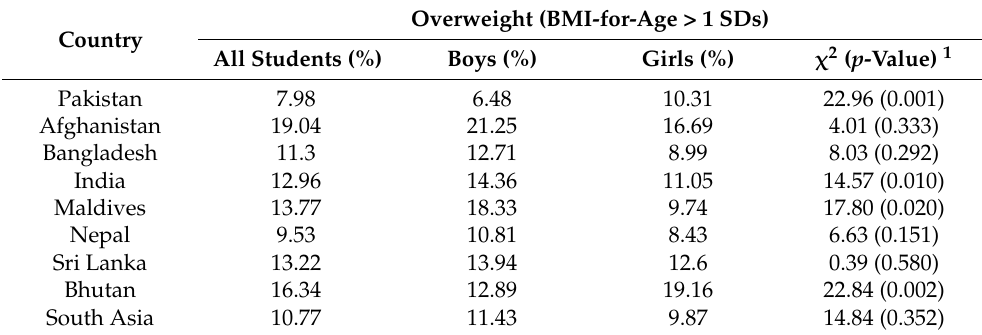
Table 4. Prevalence * of overweight among South Asian schooled adolescents aged 12–15 years. Overweight (BMI-for-Age > 1 SDs) Country All Students (%) Boys